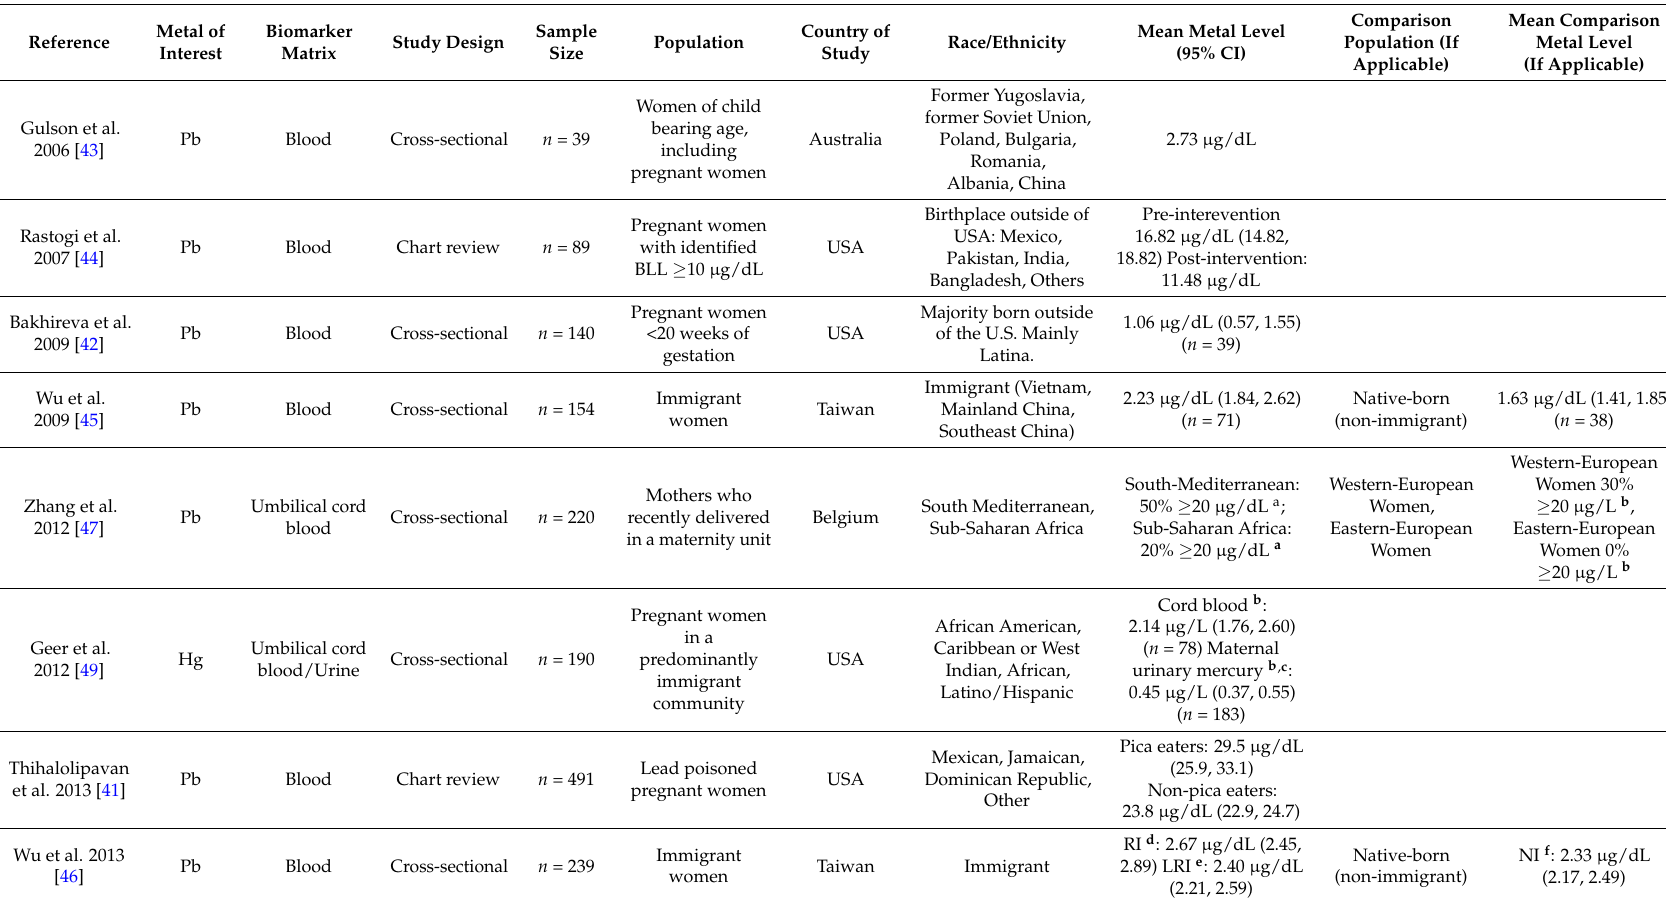
Table 1. Studies reporting biomarker lead, mercury and cadmium concentrations in newcomer